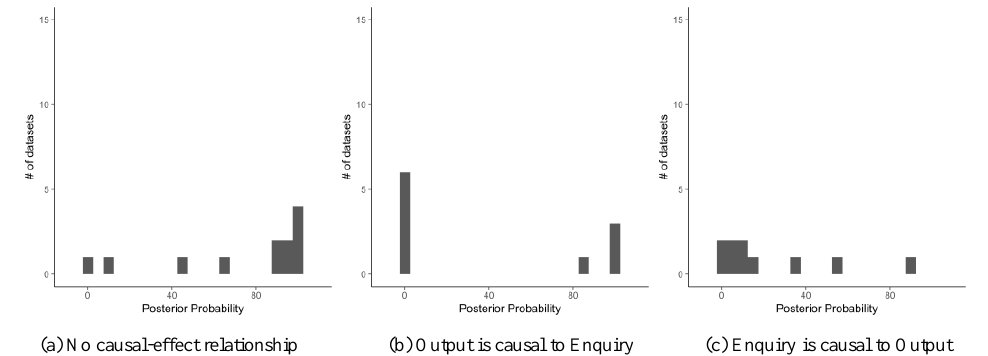
Fig. 6. Distributions of posterior probabilities between Output and Enquiry in China dataset when the number of bootstrap samples is 15